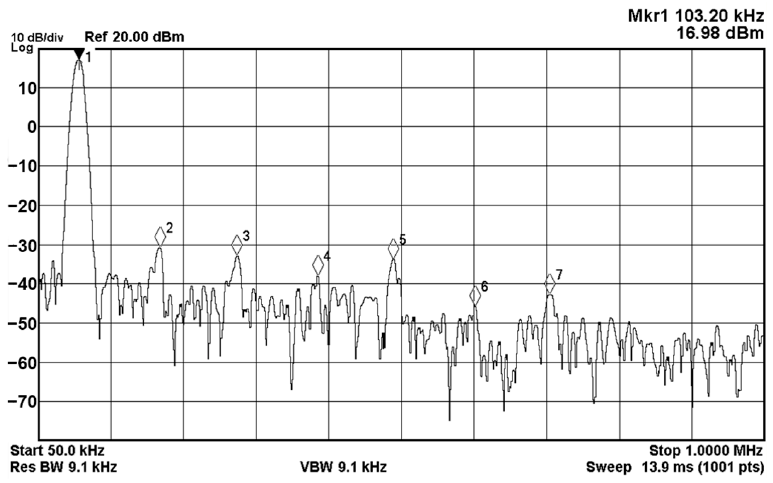
Figure 18. The experimental results. ( a ) The quadrature voltage outputs V o1 (blue) and V o2 (cyan); and ( b ) X-Y pattern.